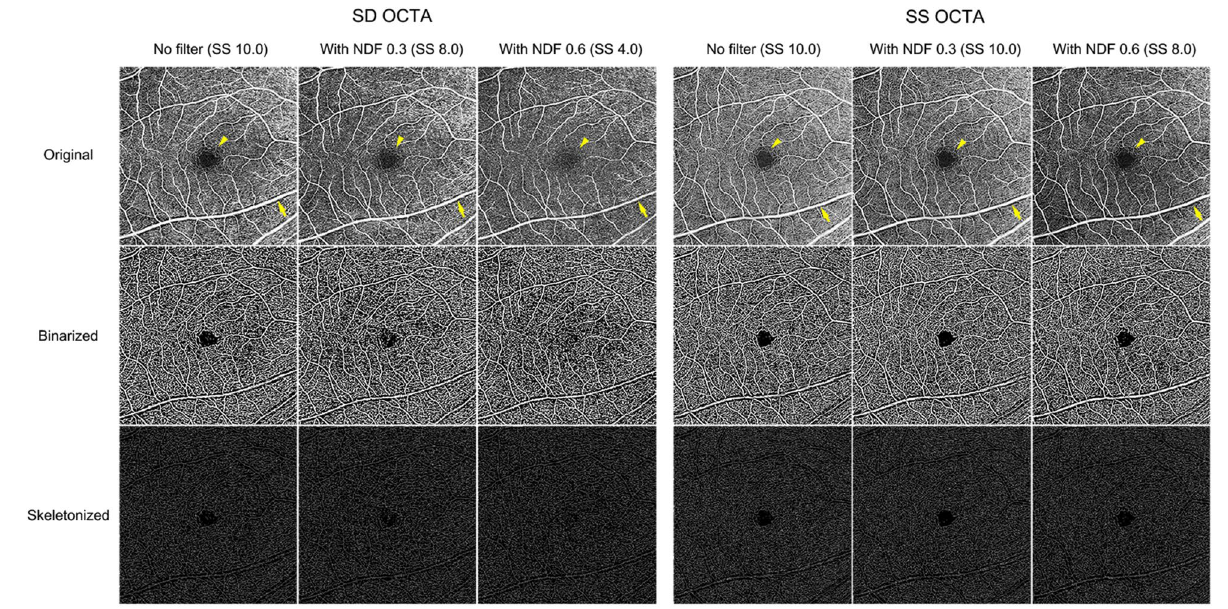
Figure 1. Representative 6 × 6 mm en face superficial capillary plexus (SCP) optical coherence tomography angiography (OCTA) images with application of neutral density filter (NDF) of a 35-year-old healthy male subject. Signal strength (SS) decreased significantly with spectral domain OCTA (SD-OCTA) compared to swept-source OCTA (SS-OCTA). The large retinal vessels tended to be narrower (yellow arrow), and the fovea avascular zone appeared fuzzier (yellow arrowhead) when SS decreased. Such SCP image changes were more obvious in the SD-OCTA than in the SS-OCTA. The vessel density (VD) was 38.0%, 36.1%, and 35.7%, and the vessel length density (VLD) was 9.9%, 9.3%, and 9.4% when SS changed, respectively. For SS-OCTA, the VD was 38.0%, 36.7%, and 36.2%, and the VLD was 11.5%, 11.1%, and 10.8%, respectively.